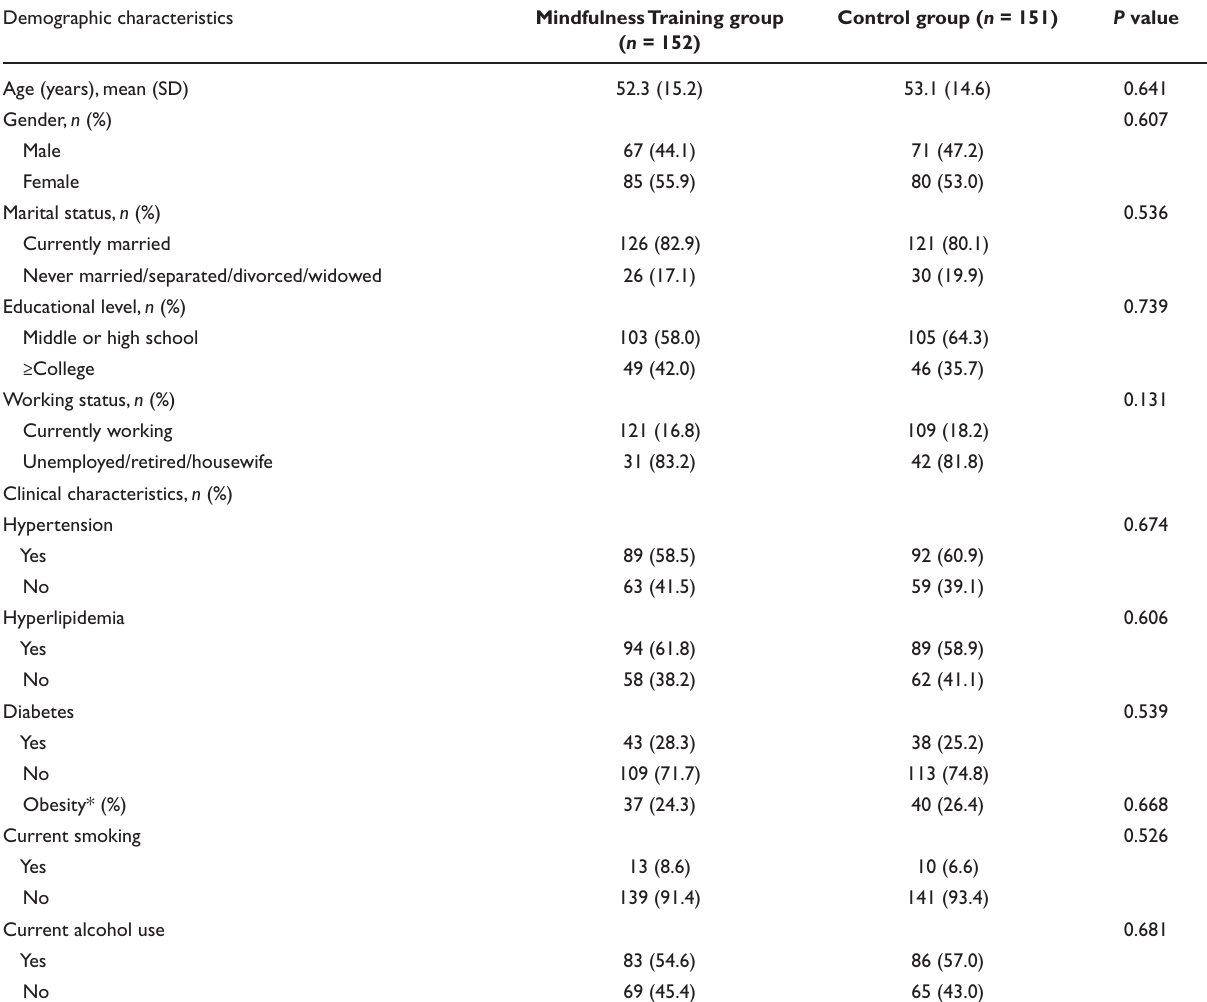
Table 1 . Baseline demographic and clinical characteristics among all the participants Demographic